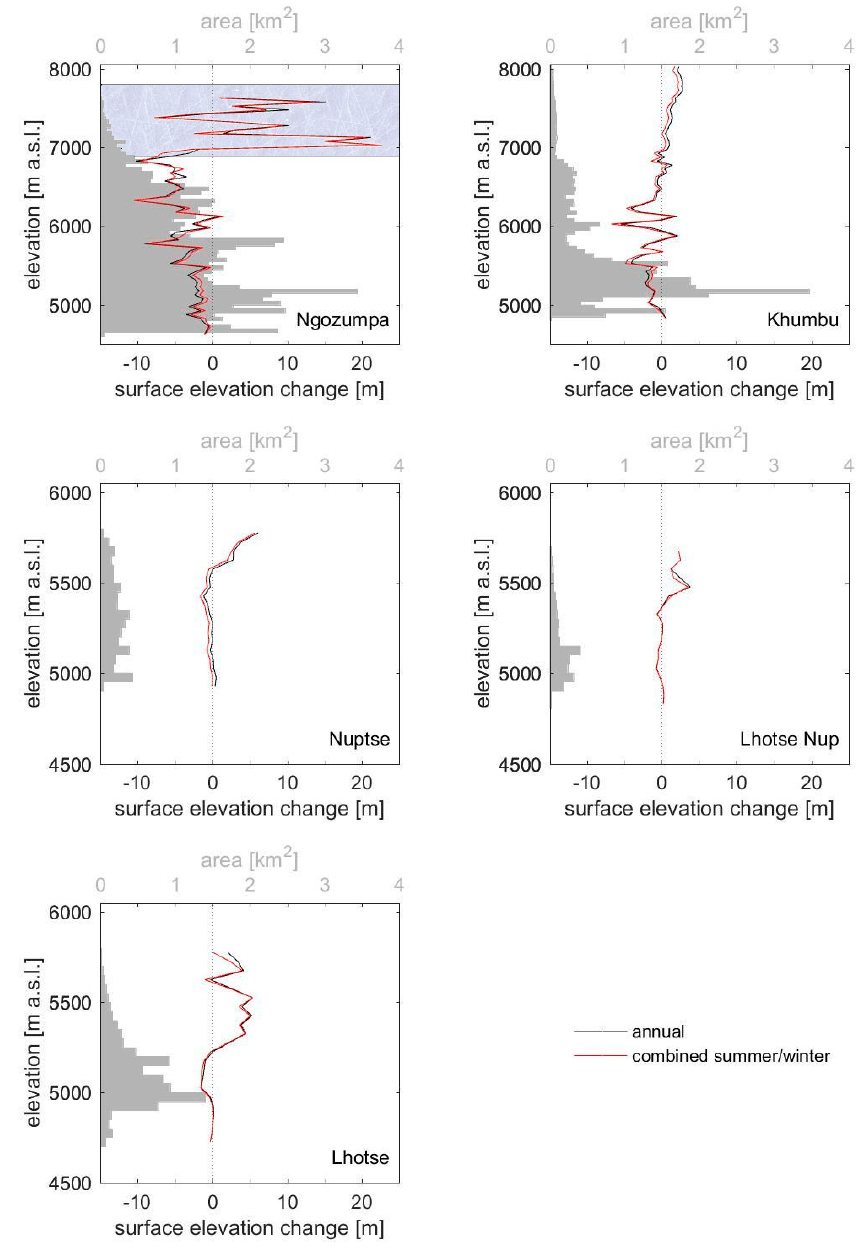
Figure 19. One-year surface elevation change of the five investigated glaciers in the Khumbu Himal. These were calculated once from spring 2015 to spring 2016 and once combined with the surface elevation changes of the spring 2015–autumn 2015 and autumn 2015–spring 2016 periods. The highest parts of Ngozumpa glacier where data quality is problematic are marked in blue.